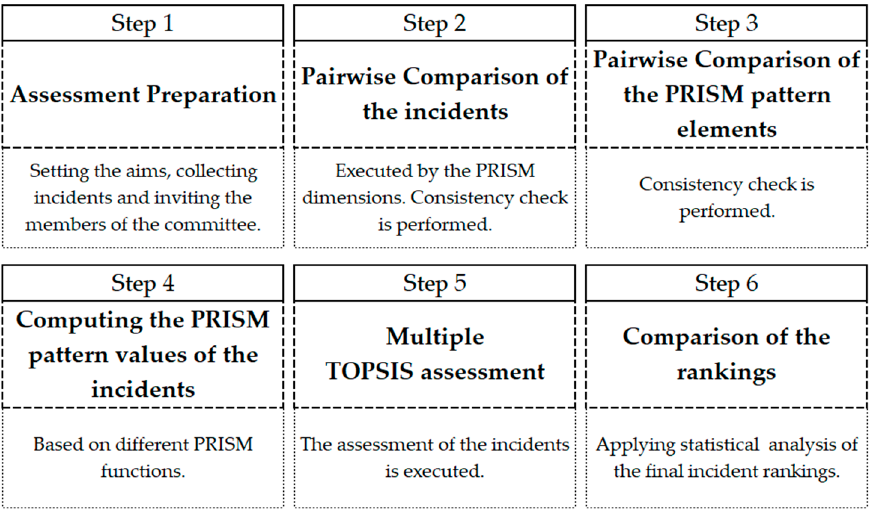
Figure 1. Primary steps of proposed pairwise-comparison-based TOPSIS-PRISM method.